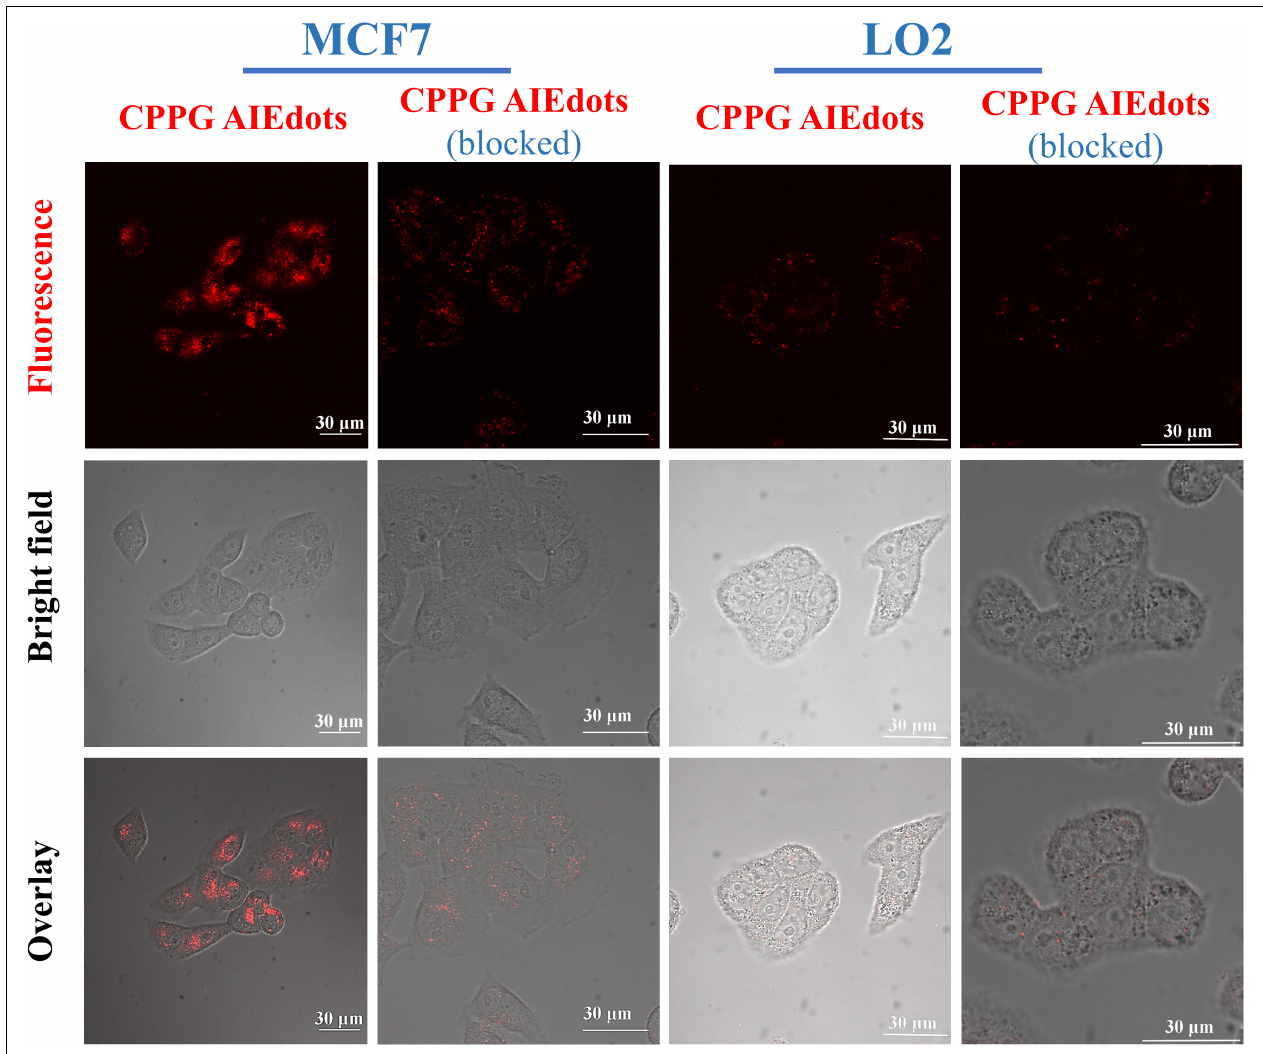
FIGURE 2 | Cancer cell targeting property of CPPG AIE dots. CLSM (Confocal Laser Scanning Microscopy) images of MCF7 cells (GLUT high-concentration) and LO2 cells (GLUT low-concentration) after incubating with CPPG AIE dots under different treatments for 3 h at 37 ◦ C. For the pre-blocking experiment, cells were pretreated with 10 mg/mL free glucosamine hydrochloride (dissolved in DMEM) for 30 min before incubation with CPPG AIE dots.